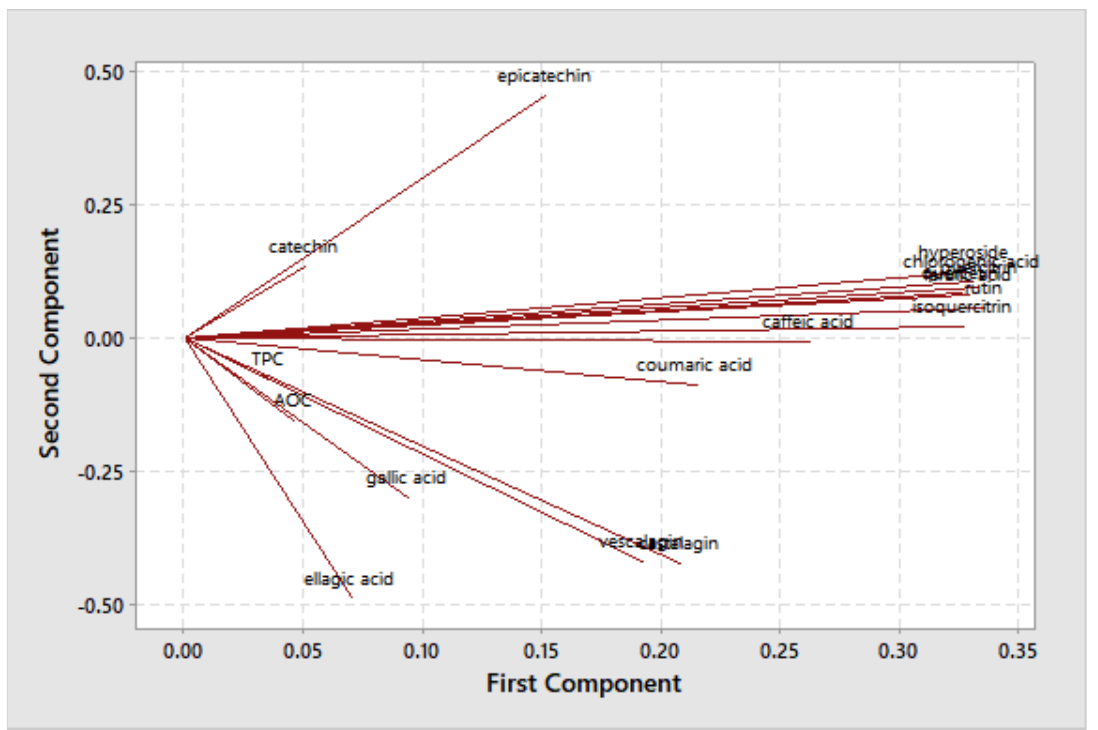
Figure 7. PCA loading plot of the selected variables. If the line referring to a specific variable is parallel to a PC, the relative phytochemical is correlated to the same PC.